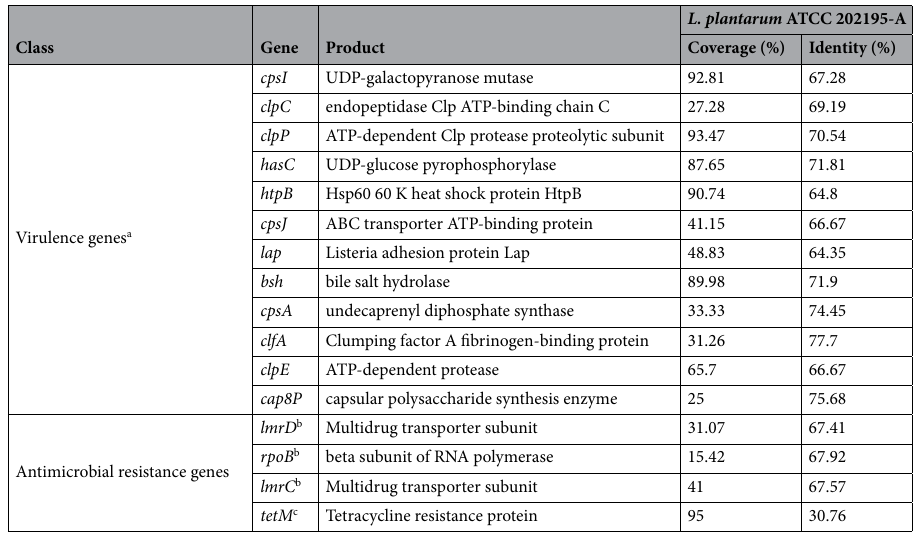
Table 3. Antimicrobial resistance genes and putative virulence genes present in the genomes of L. plantarum ATCC 2021295-A and L. plantarum ATCC 202195-B. a Virulence genes were identified by comparing DNA sequences from both isolates to the Virulence Factor Database (VFDB) 29 . b Antimicrobial resistance gene were identified using ABRicate 30 and The Comprehensive Antibiotic Resistance Database (CARD) 28 , and initial results were verified by BLASTn 31 . c L. plantarum ATCC 202195 gene loci G9282_00305 compared